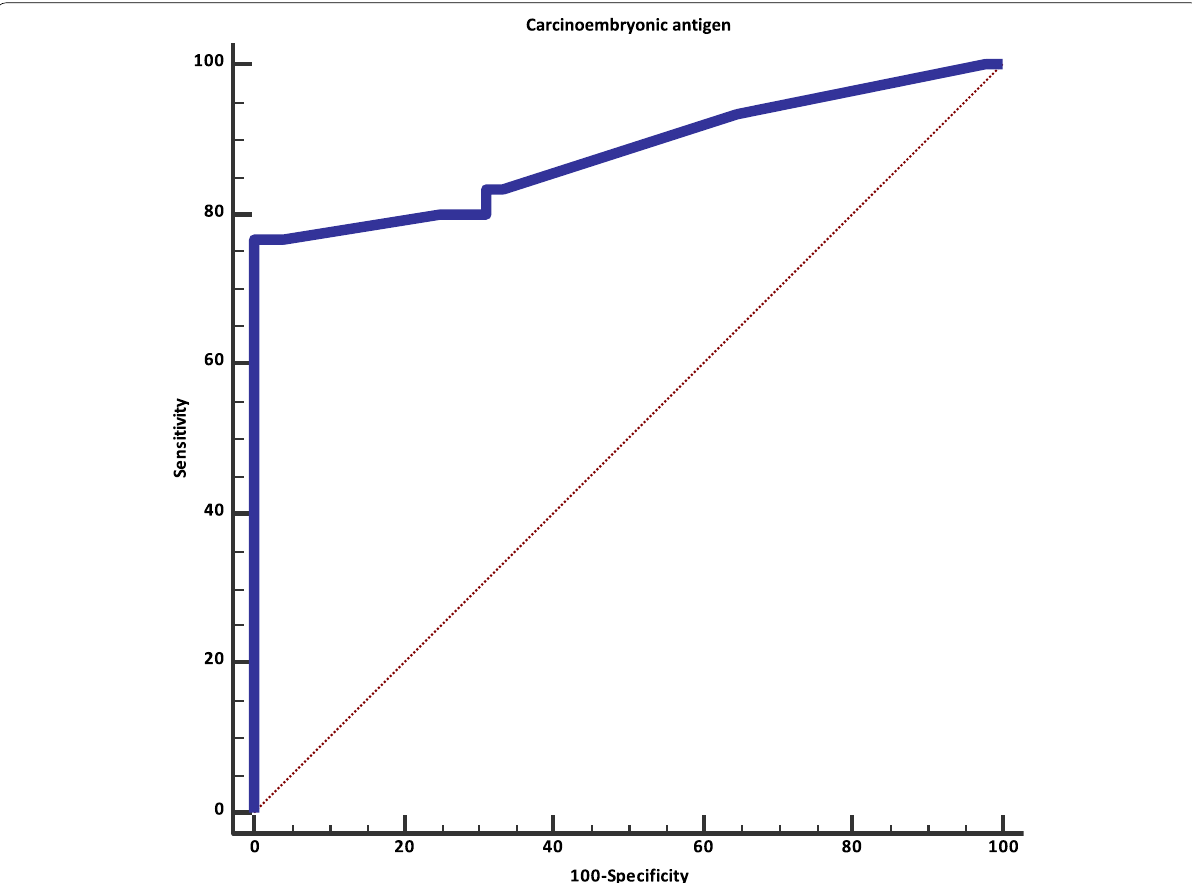
Fig. 2 The accuracy of serum level of CEA in diagnosis of malignant pleural effusion. At cutoff point > 5 ng/ml in serum; CEA had 77% sensitivity and 100% specificity in diagnosis of malignant pleural effusion with overall accuracy was 91.1% and area under curve was